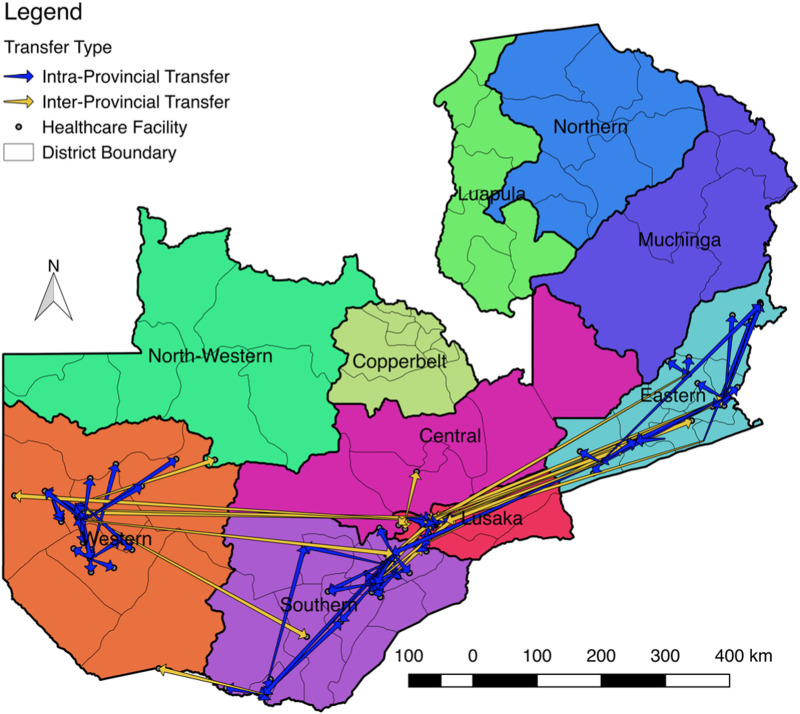
Transfers across study provinces.Inter and intra provincial transfer of patients originally identified as silent transfers.